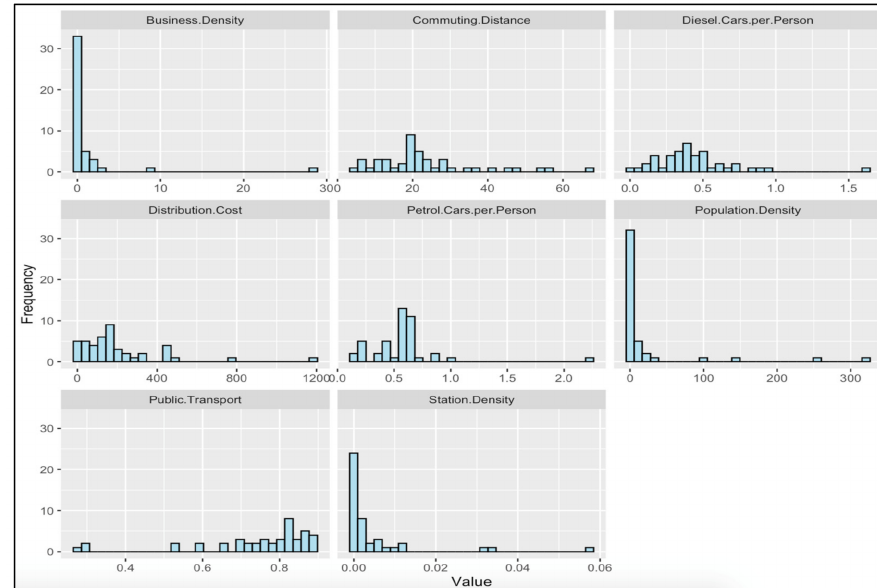
Figure 2. Histograms of attributes.